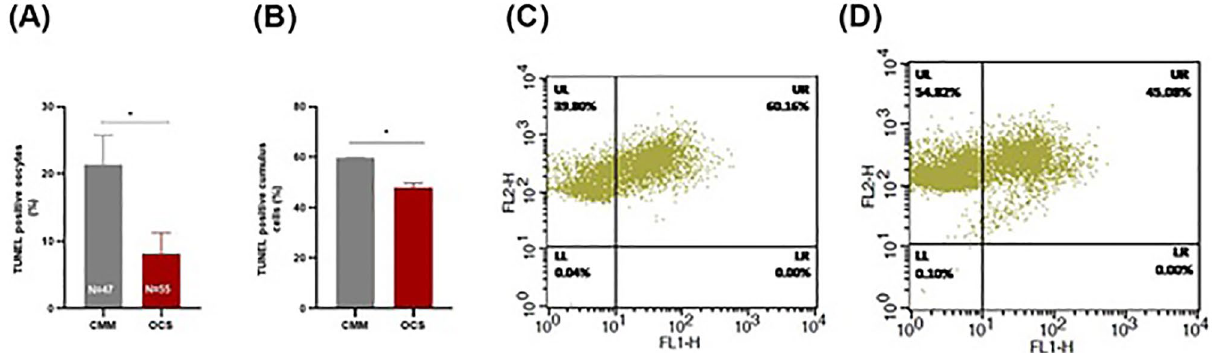
Figure 5. Effect of one carbon supplementation on DNA fragmentation in oocyte and cumulus cells. ( A ) TUNEL positive oocytes (%) in CMM and OCS group (4 replicates). ( B ) TUNEL positive cumulus cells (%) in CMM and OCS group (3 replicates). ( C ) Flow cytometry histograms indicating cumulus cell DNA fragmentation in CMM and ( D ) OCS. The data are shown as mean ± s.e.m. *Stands for P ˂ 0.05. N stands for number of TUNEL positive oocytes/total number of